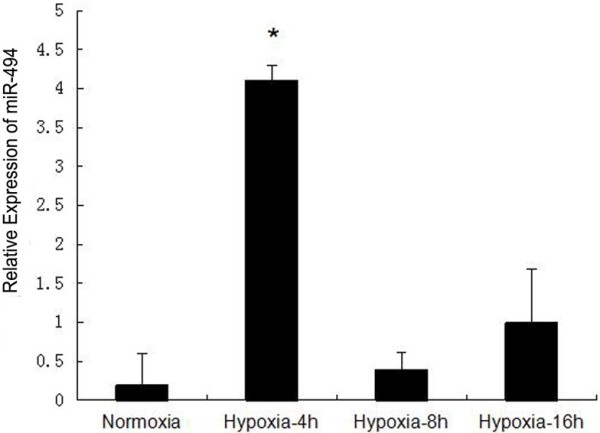
Hypoxia induced upregulation of miR-494 in L02 cells. Cells were incubated under hypoxia (1%O2, 5%CO2 in a 37°C incubator) for 4 hours, 8 hours, and 16 hours, followed by analysis for miR-494 expression by real-time qRT-PCR. U6 small nuclear RNA was used as an internal control. The data were presented as the means ± SD. Columns, mean of three independent experiments; bars, SD; *p < 0.05 compared to other three groups.